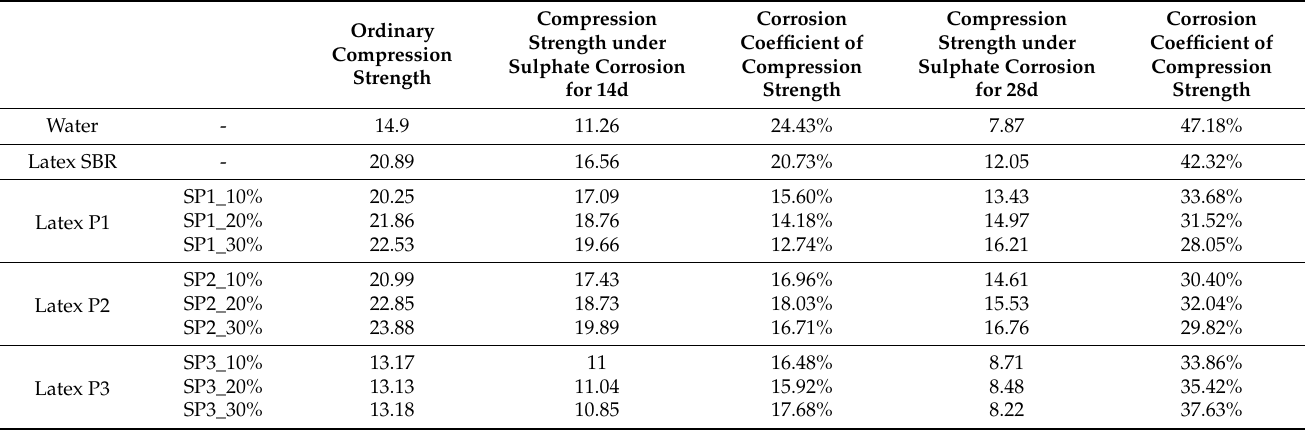
Table 7. Sulphate corrosion test